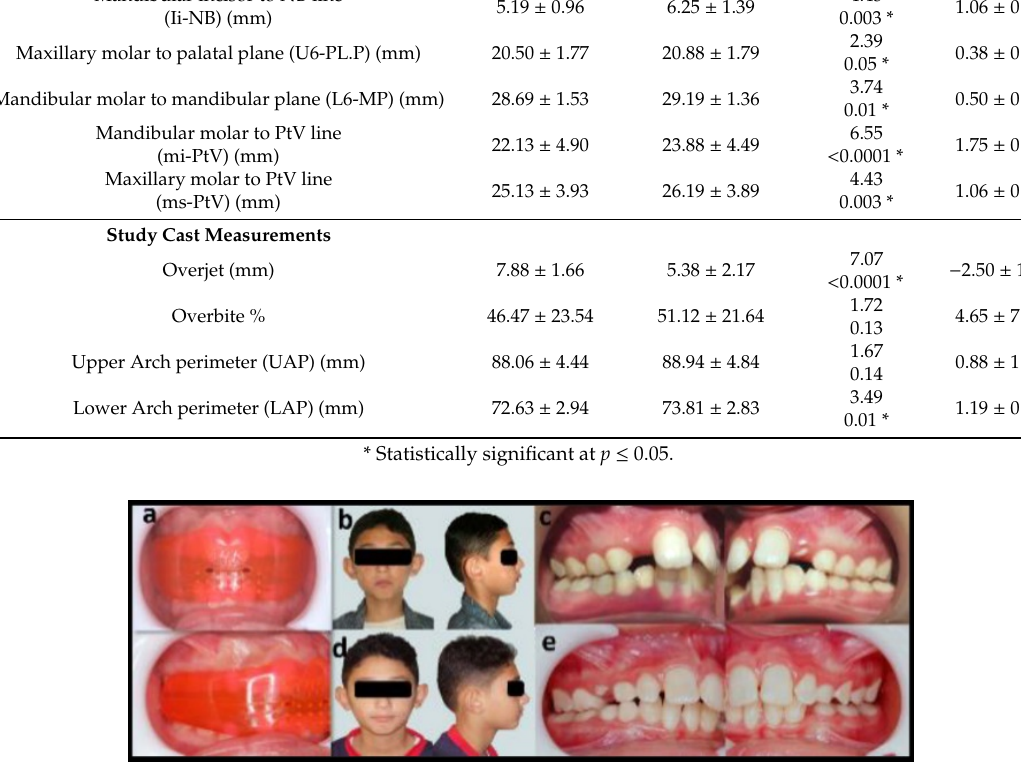
Figure 3. Photographs showing the T4K myofunctional appliance group: ( a ) intraoral frontal and lateral views of the appliance inside patient’s mouth; ( b ) preoperative frontal and lateral extraoral views showing a convex profile and incompetent lip seal; ( c ) preoperative right / left lateral intraoral views showing class II canine and molar relation; ( d ) postoperative frontal and lateral extraoral views showing a complete lip seal and straight facial profile; ( e ) postoperative right / left lateral intraoral views showing class I canine and molar relation and reduced overjet.